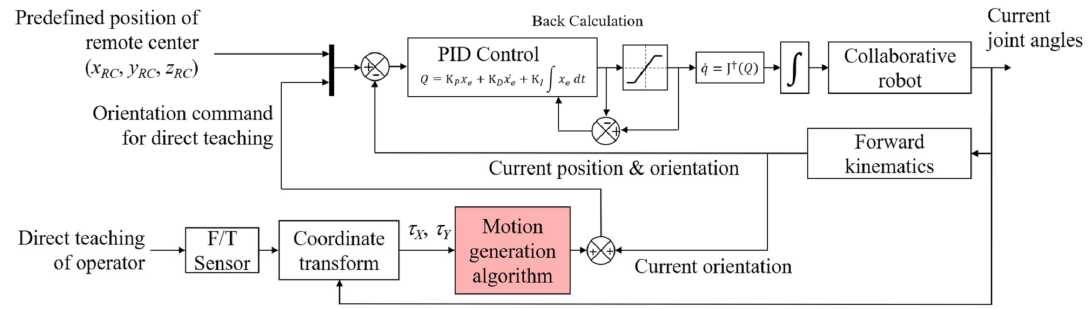
Figure 3. Block diagram of RCM control with motion generation